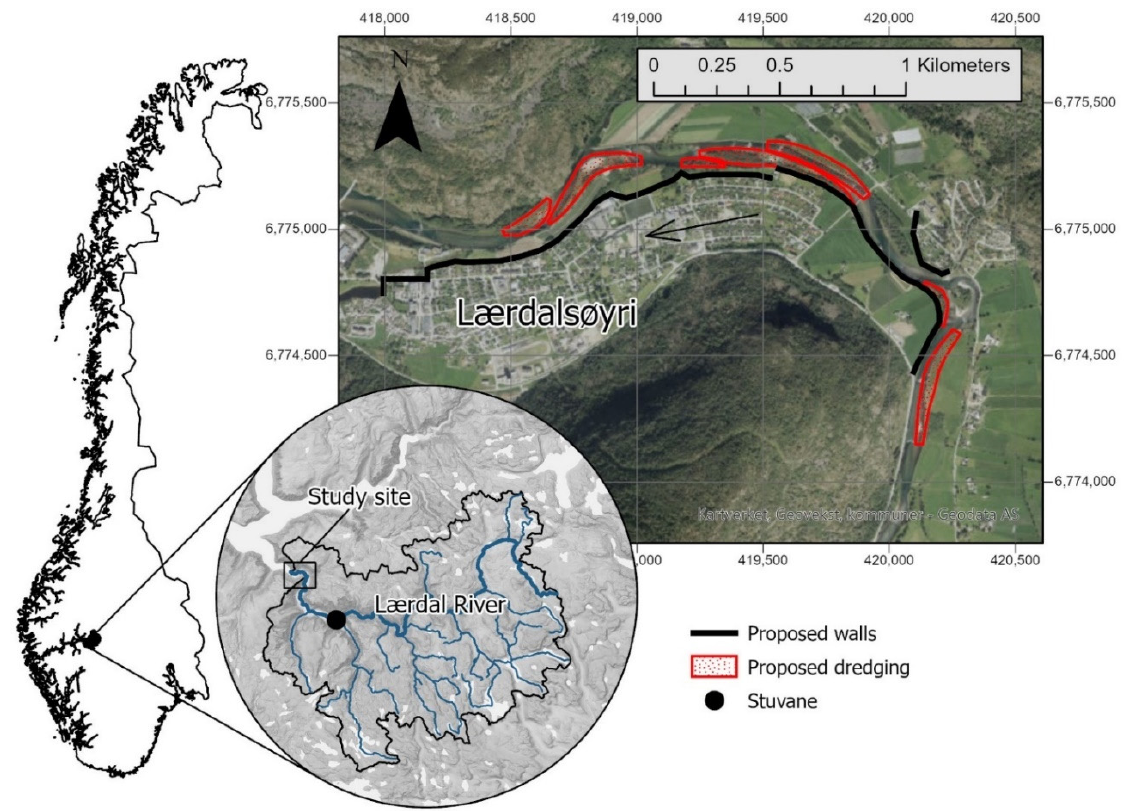
Figure 1. Illustration of Lærdal catchment location in Norway, location of the selected study area in the lowermost part of the river, Lærdalsøyri village, and proposed walls and dredging in the riverbed.